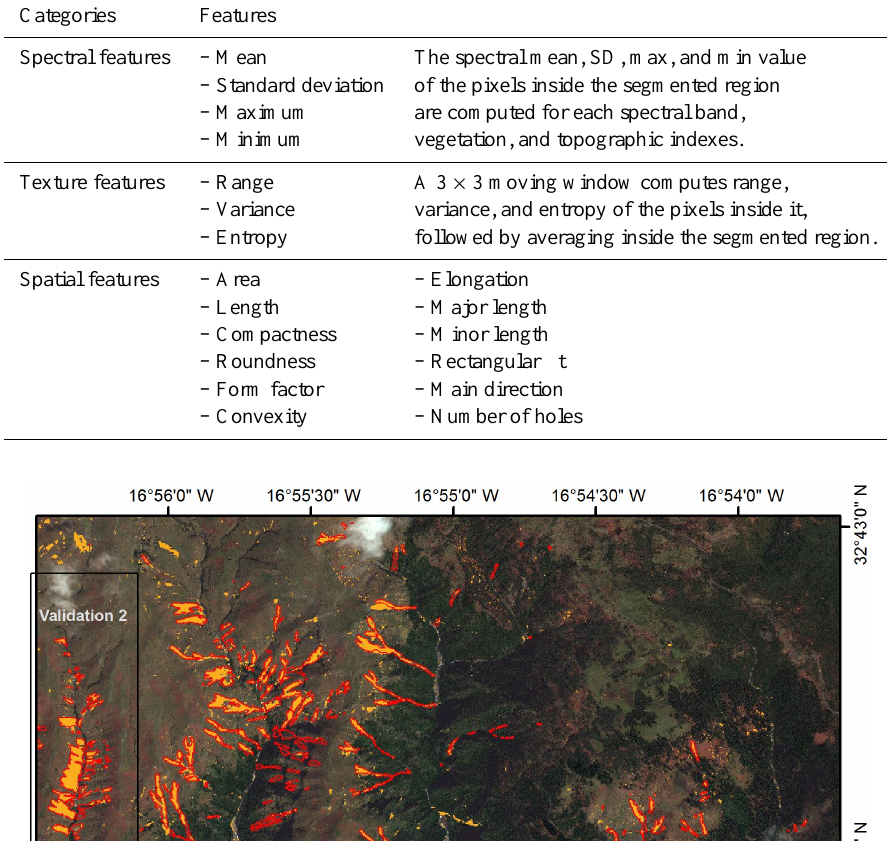
Table 2. Features used for object-based learning.